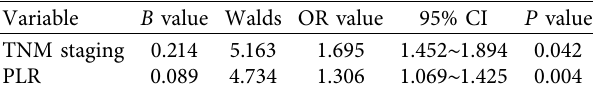
Table 3: Multivariate logistic analysis on the effect of chemo- therapy in patients with advanced NSCLC (Assignment situation: “TNM stage IIIb” � “0”; “TNM stage IV � ”1”. “PLR < 197” � “0”; “PLR ≥ 197” � “1”).